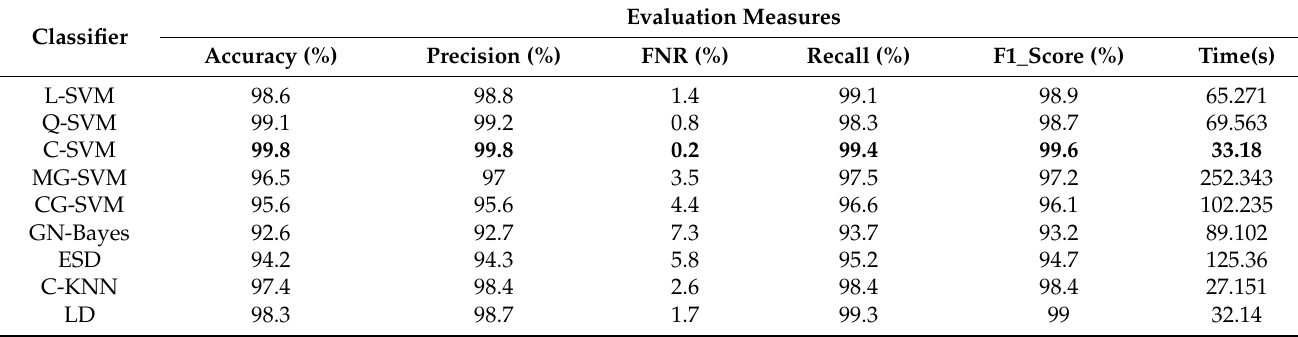
Table 2. Stomach disease classification with proposed feature optimization technique (CV =